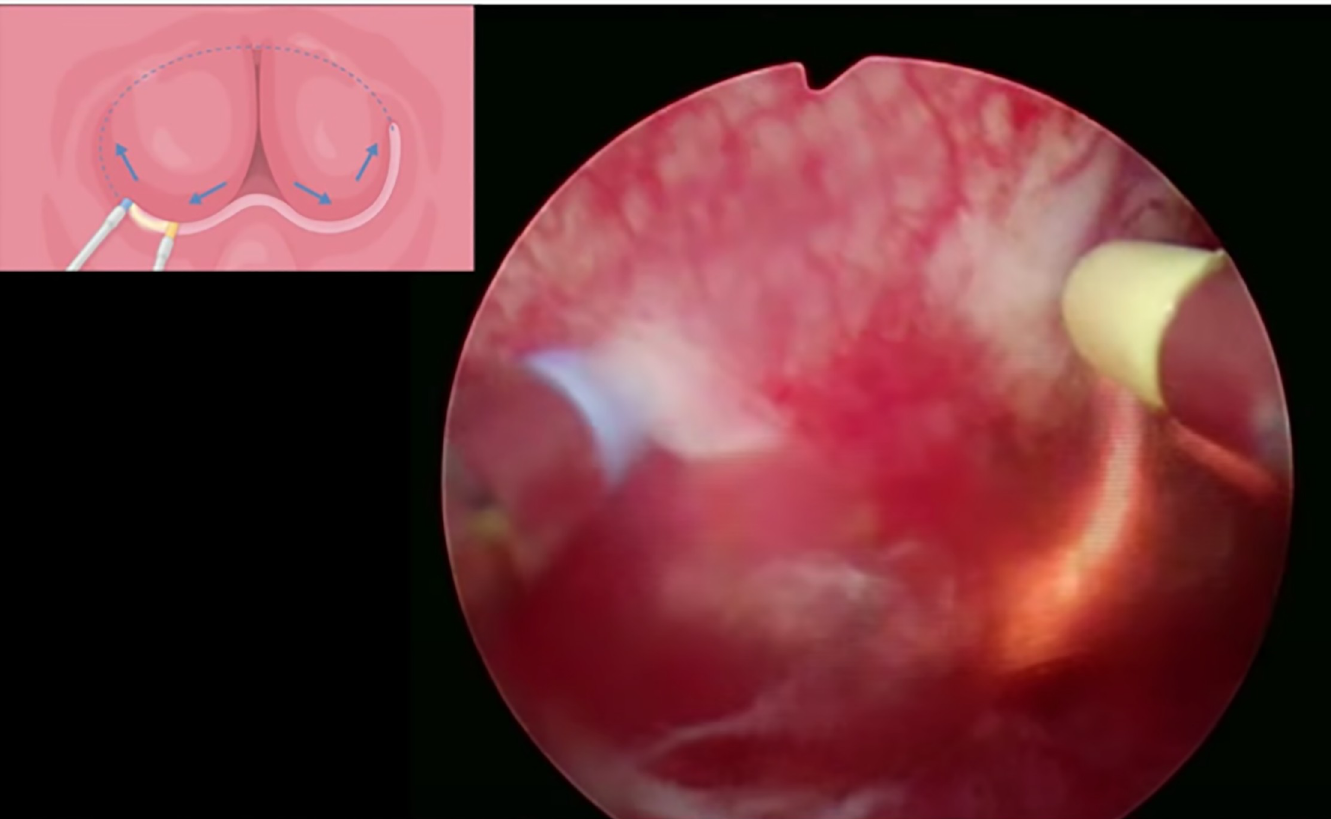
Fig 2. After creating a groove at the 12 o’clock position, two additional grooves are performed at the 5 and 7 o’clock positions, laterally to the veru